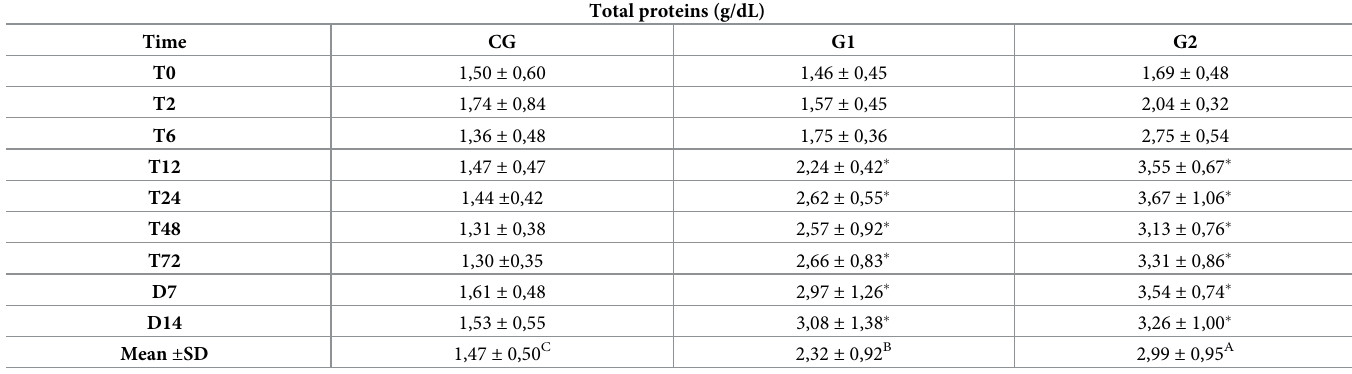
( � ) represent differences compared to baseline time (T0) within the group; Different capital letters represent differences between groups at the same time; p � 0.05.